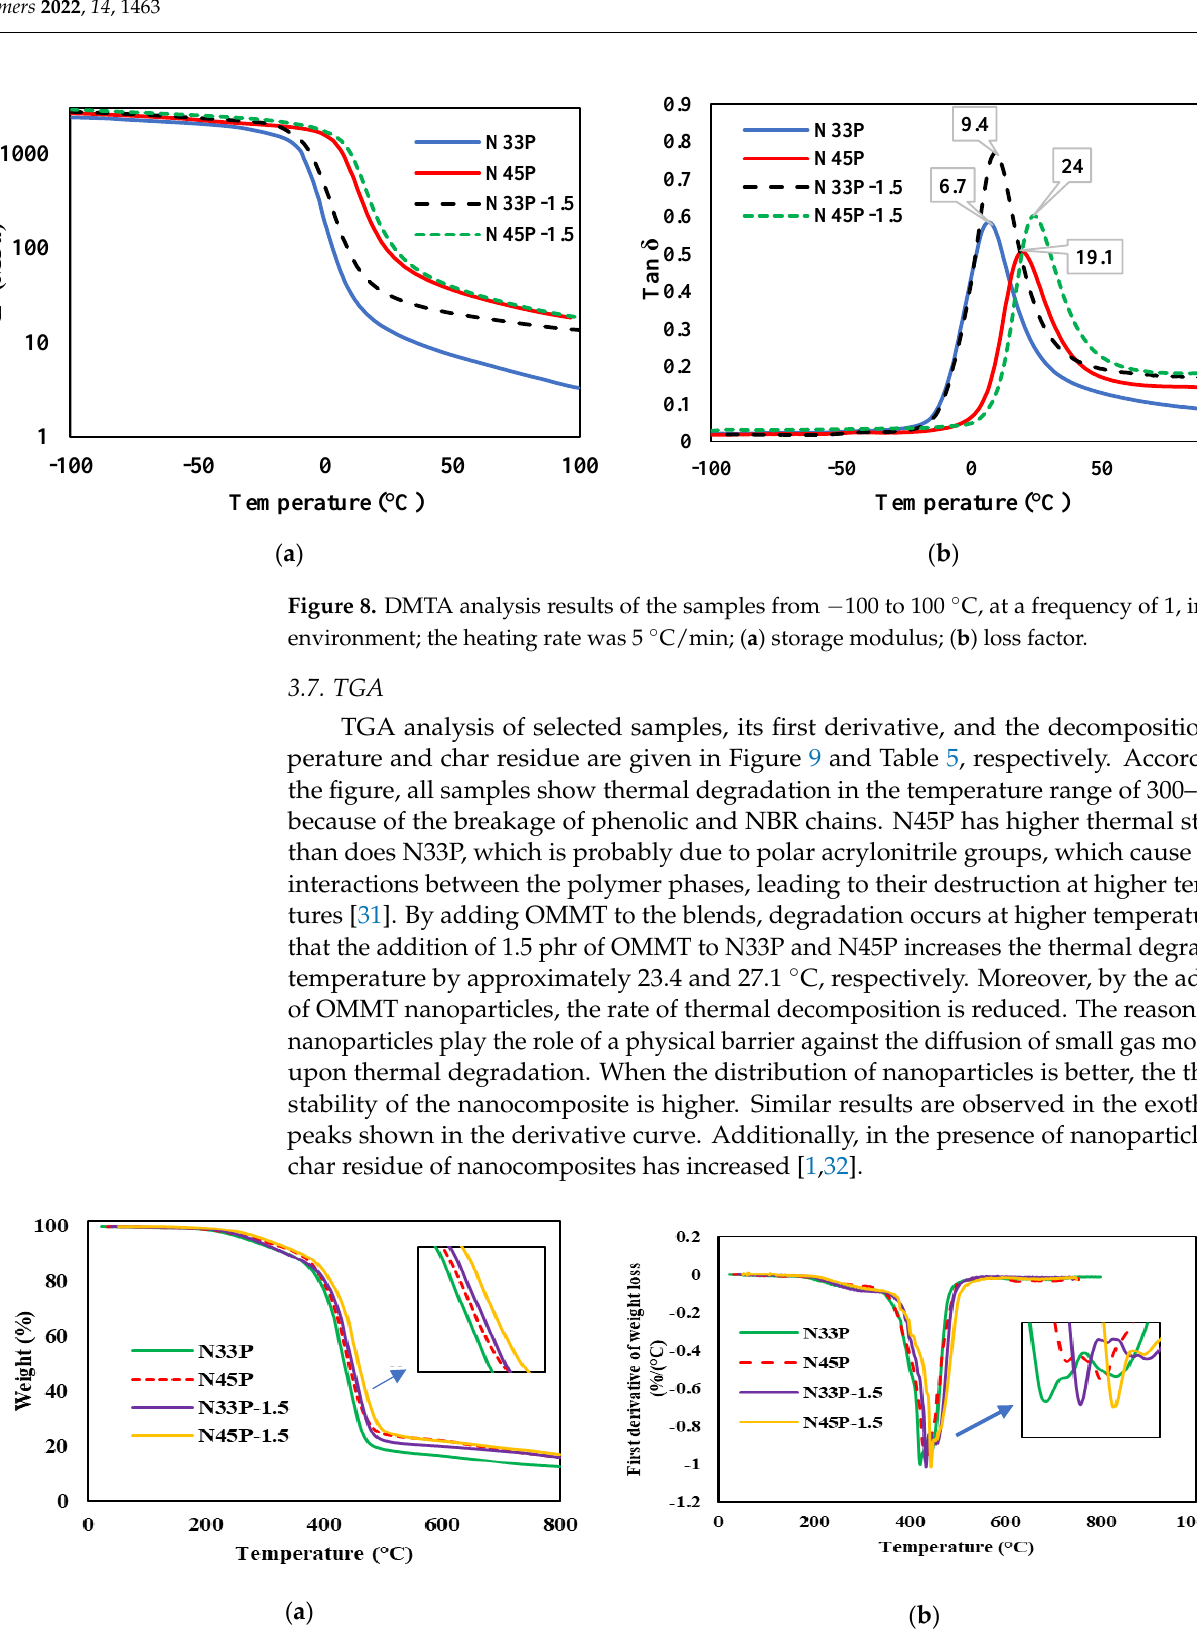
Figure 9. TGA analysis of the blends and nanocomposites conducted from 25 to 800 °C at a heating rate of 10 °C/min; ( a ) weight vs. temperature; ( b ) its first derivative.